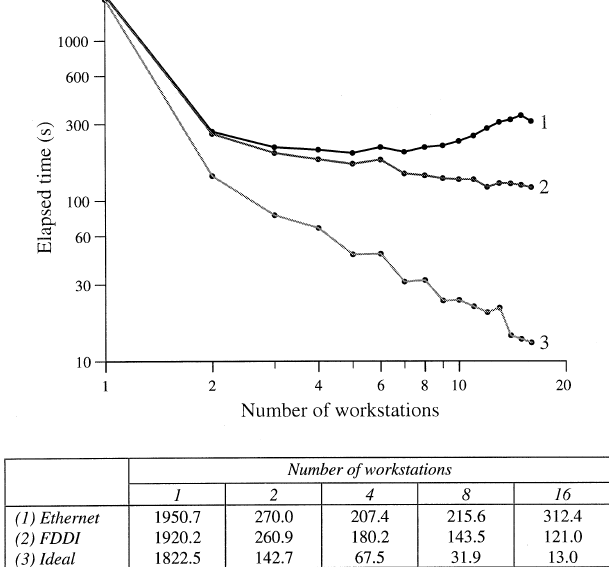
Fig. 2. The elapsed time required to model one day of a two-degree global model, with 32 levels, is plotted for runs using 1 to 16 workstations connected via (1) Ethernet, (2) FDDI and (3) a hypothetical, infinitely fast interconnect. For clarity, the table highlights a selection of the